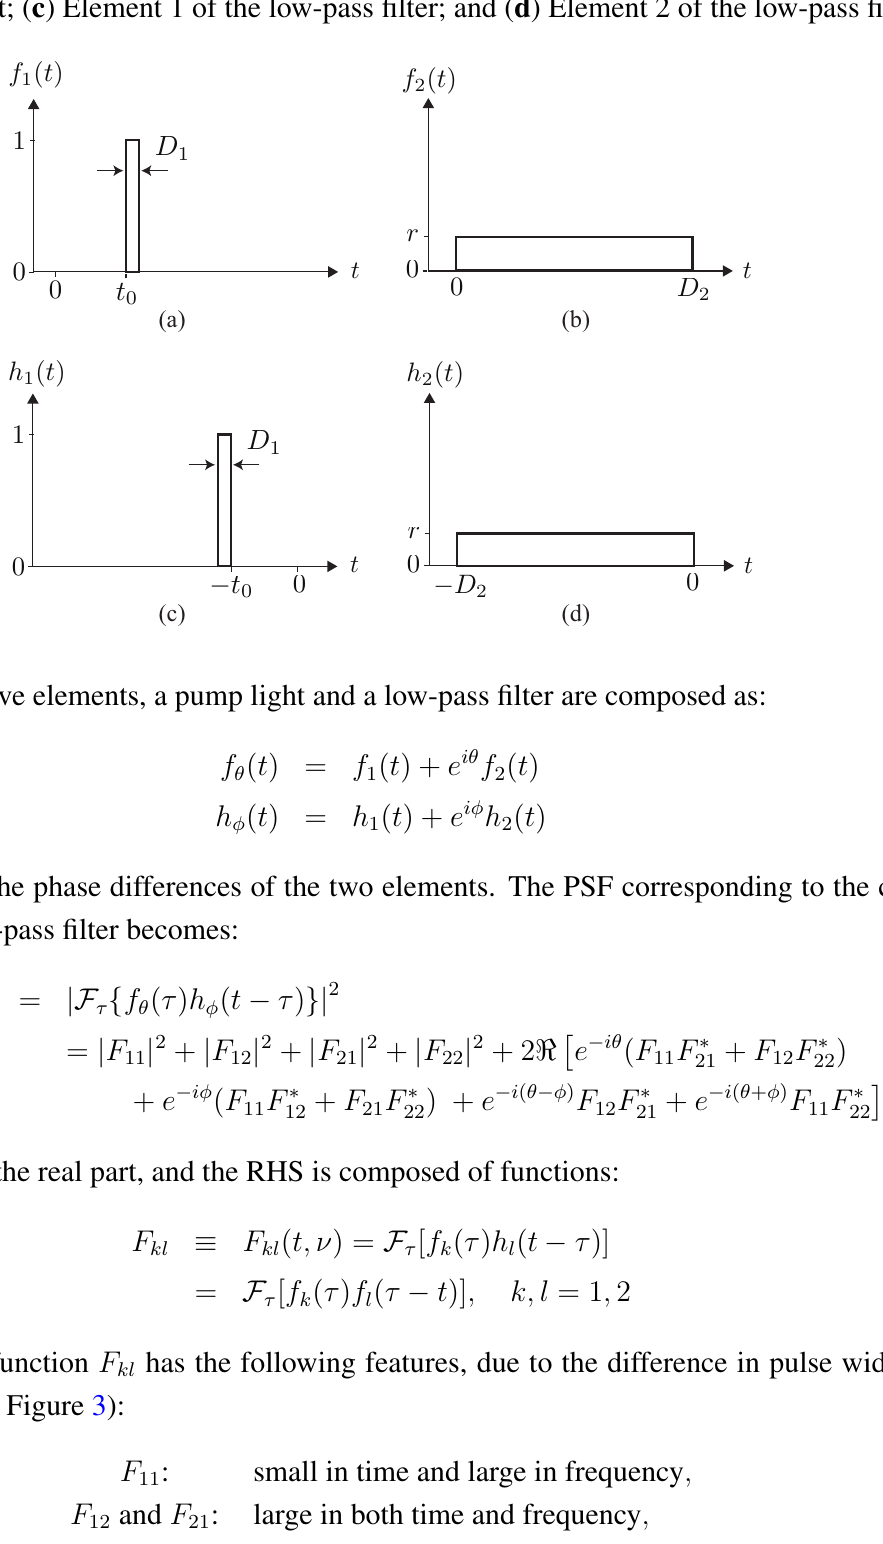
Figure 2. Pump lights and matched filters: ( a ) Element 1 of the pump light; ( b ) Element 2 of the pump light; ( c ) Element 1 of the low-pass filter; and ( d ) Element 2 of the low-pass